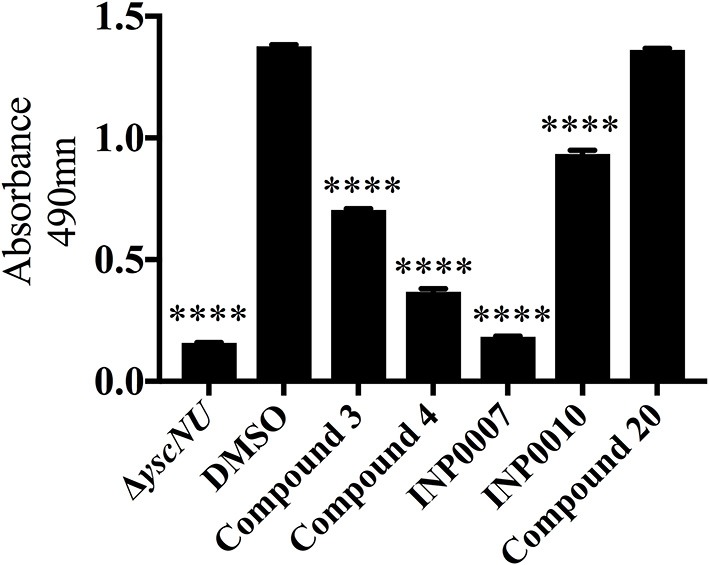
Secretion of YopM-Bla into the culture supernatant. Y. pseudotuberculosis Δyop6 expressing the Yop reporter YopM-Bla were grown under T3SS-inducing in vitro conditions for 2 h in the presence of 50 μM compound or equivalent volumes of DMSO and cleavage of the β-lactamase substrate nitrocefin used to measure the relative quantity of secreted YopM-Bla. The average of three independent experiments ± standard deviation are shown and statistical significance is represented comparing compounds relative to the DMSO control. ****P < 0.0001 (one way ANOVA with Dunnett's post-hoc test).